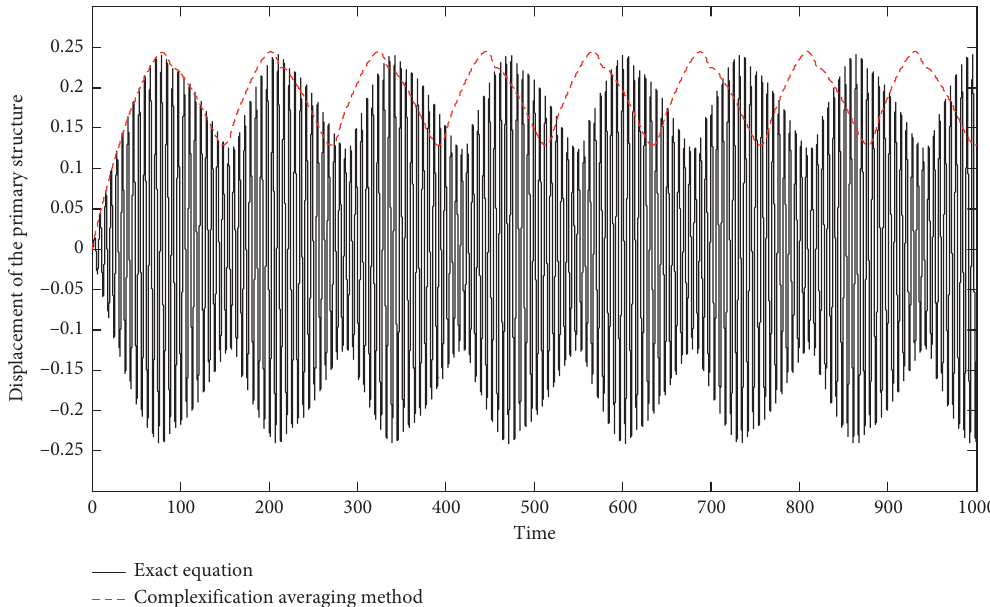
Figure 2: Time-history curves of the primary structure for the case λ